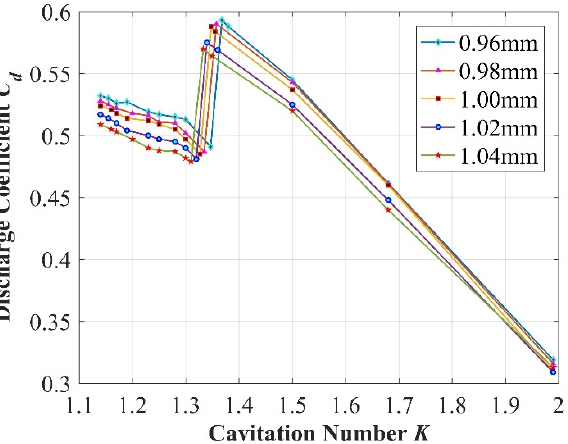
Figure 12. Relationship between the discharge coefficient and cavitation number of single small de- viation cylindrical nozzles. deviation cylindrical